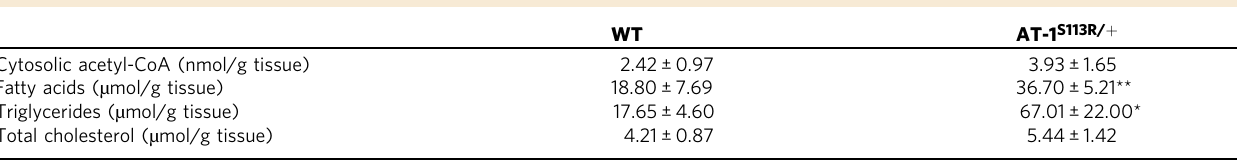
Hepatic lipid content of WT ( n = 5) and AT-1 S113R/ + ( n = 5) mice fed a standard diet. One-tailed Student ’ s t test. * P <0.05; ** P